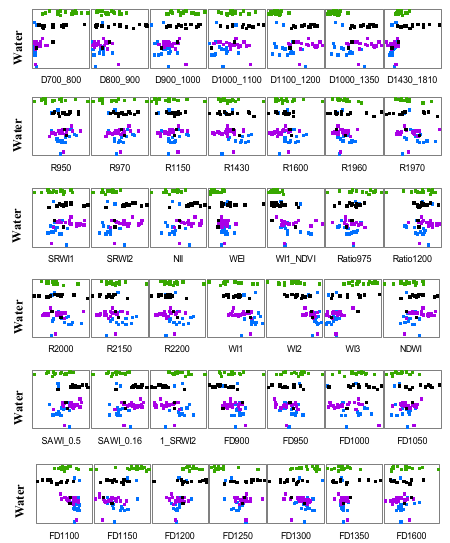
Figure 5. Rice nitrogen sensitive index matrix Figure 6. Correlation between rice water contend and its